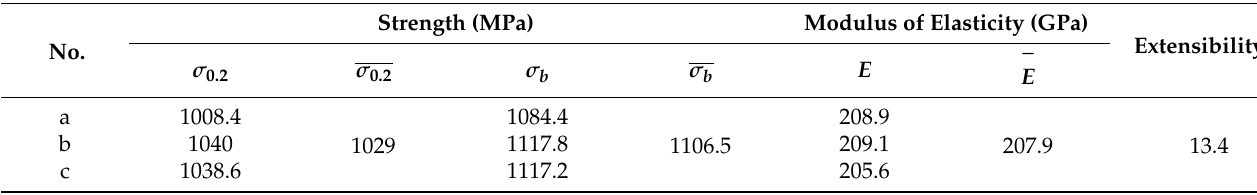
Figure 4. Schematic diagram of test loading. Table 2. Test results for high-strength